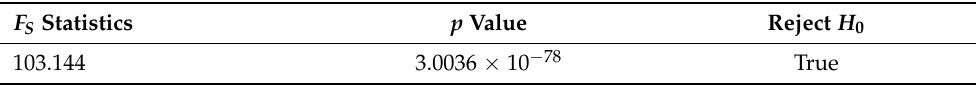
Table 4. One-way ANOVA F S statistics and P value for the null hypothesis of scores being equal for all groups. The hypothesis H 0 : µ 1 = µ 2 = µ 3 = α > 1 −